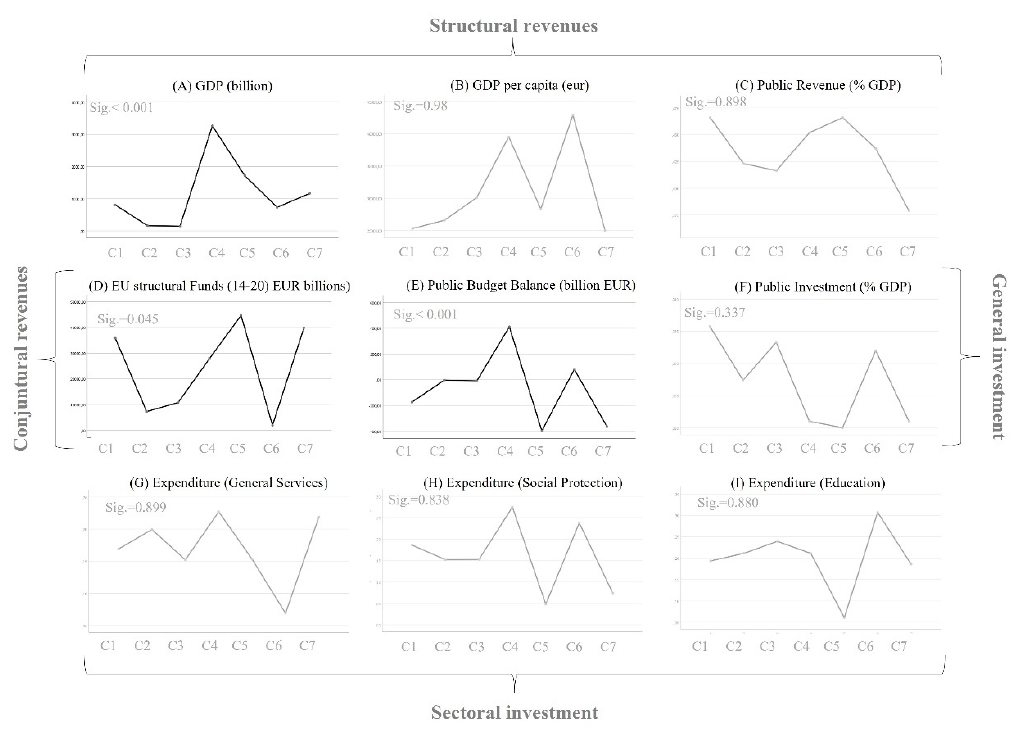
Figure 11. Socio-economic profile of territorial clusters of categories typologies (initiatives).